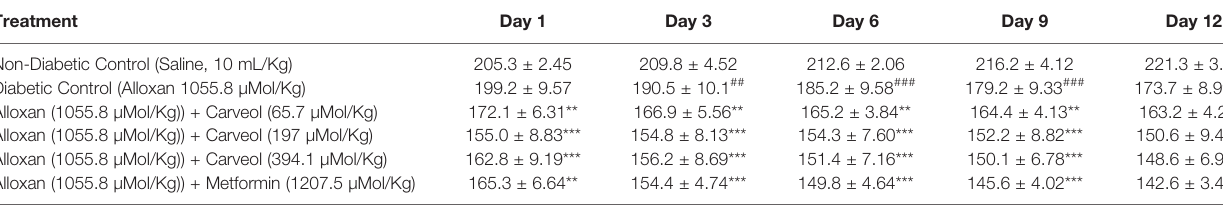
TABLE 3 | Effect of carveol and metformin on different treatment days on body weight (g) of alloxan-induced diabetic rats. Treatment Non-Diabetic Control (Saline, 10 mL/Kg) Alloxan (1055.8 µMol/Kg)) + Carveol (65.7 µMol/Kg)